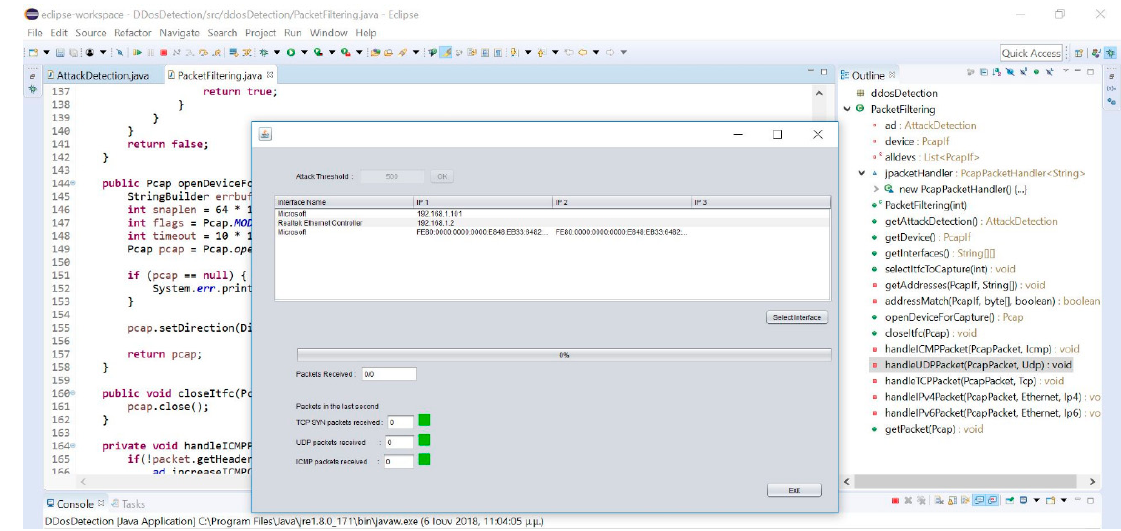
Figure 6. GUI and network devices.